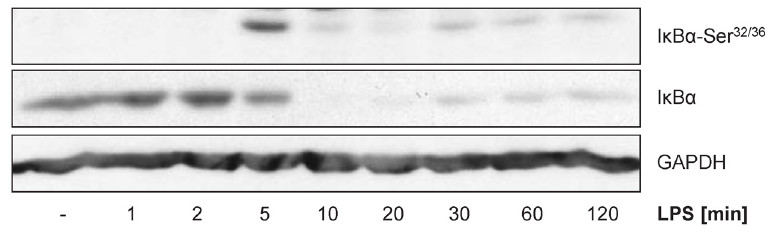
Fig 7. LPS dependent I κ B α serine phosphorylation and degradation. Primary murine BMDMs were stimulated with LPS (50 ng/ml) for the times indicated. Whole cellular extracts were prepared. I κ B α serine phosphorylation and I κ B α protein expression was analyzed by Western Blot (60 μ g of protein/lane). GAPDH served as loading control. Representative data for two independent experiments are